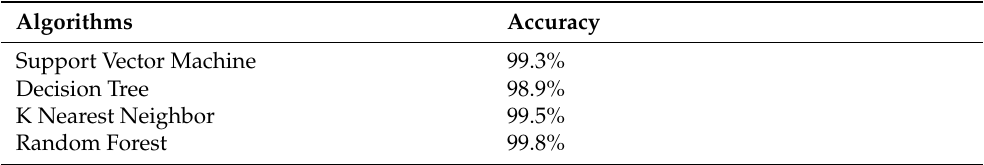
Table 1. Accuracy of the models used in the current study.